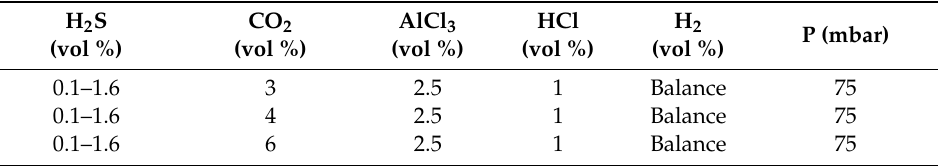
Table 1. Deposition parameters for multilayer